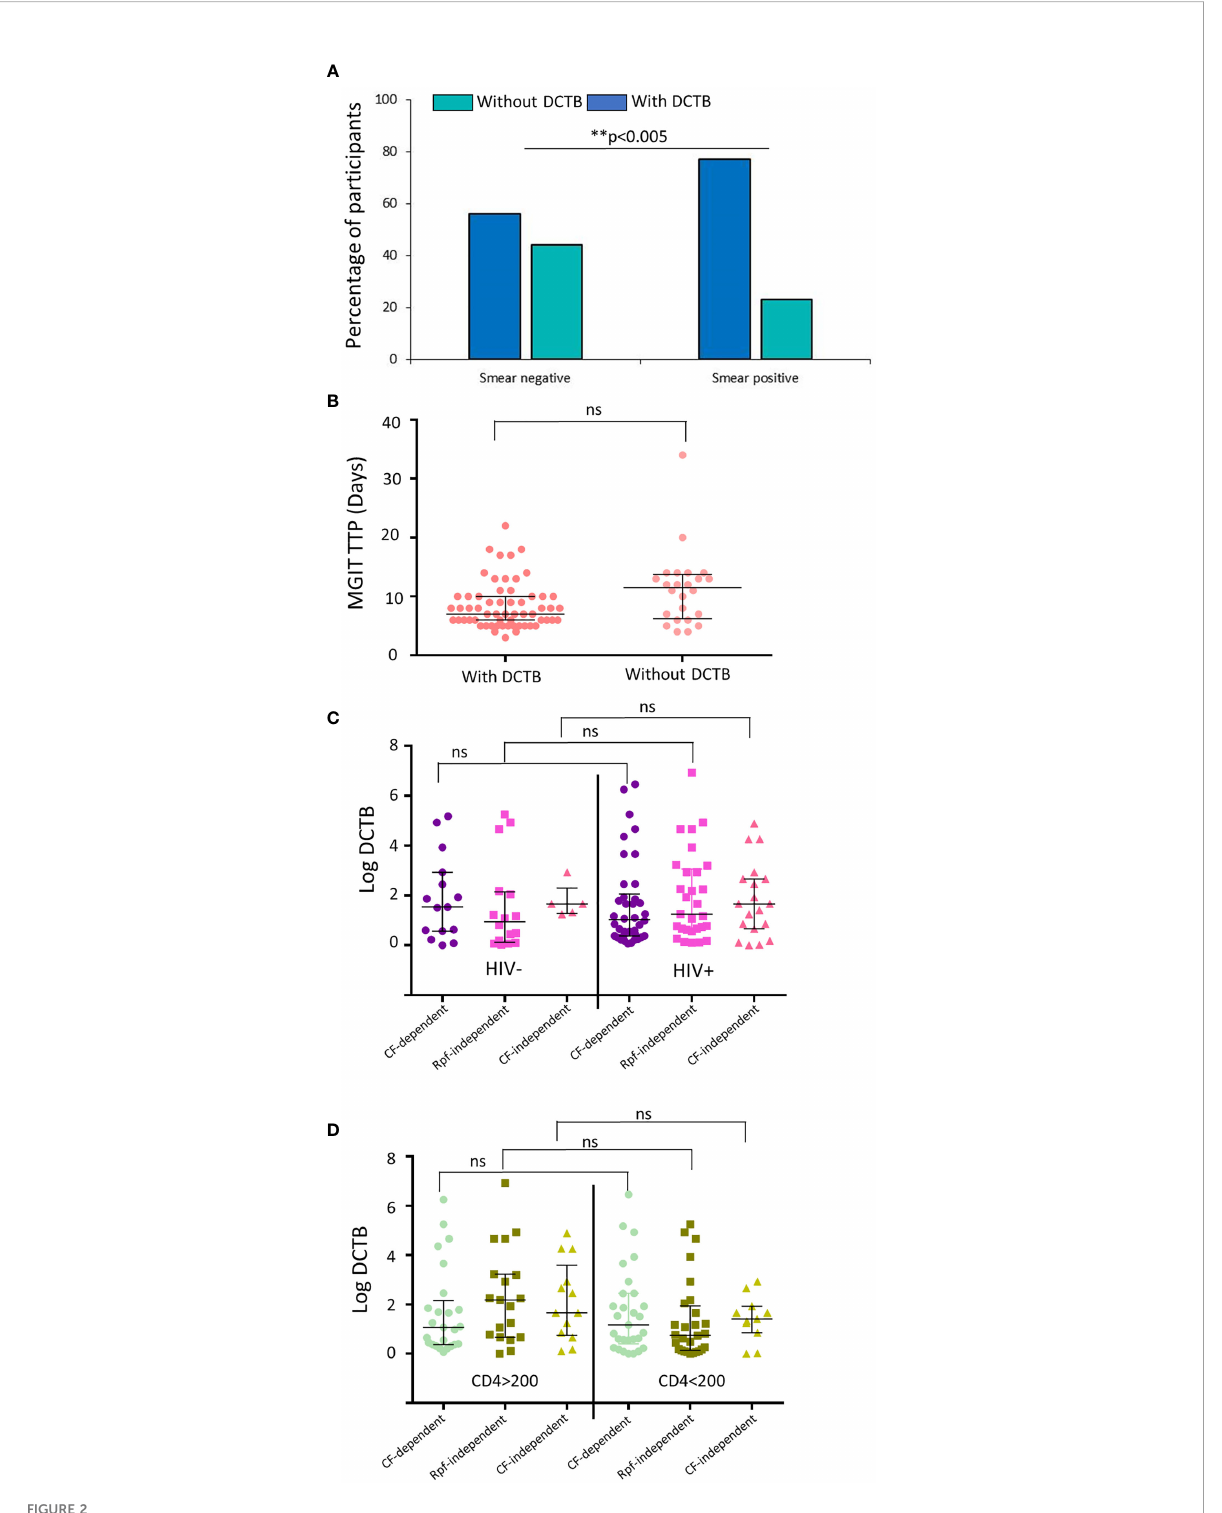
FIGURE 2 Prevalence of DCTB based on the laboratory diagnostics and HIV status of the participants. (A) Proportion of participants with (dark blue) and without (teal) DCTB based on their smear status. (B) Median mycobacterial growth indicator tube time to positivity (MGIT TTP) in specimens with and without DCTB. (C) Median DCTB (MPN/CFU) counts in specimens from participants strati fi ed by HIV status. (D) Median DCTB (MPN/ CFU) counts in specimens from HIV-infected participants strati fi ed by CD4 counts. Values from specimens that had detectable levels of DCTB were used. Error bars depict the interquartile range. ** p-value <0.005 and ns, not signi fi